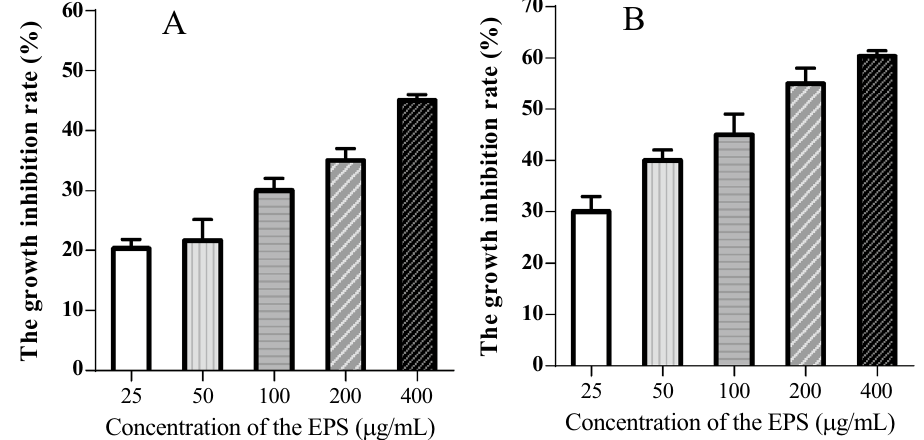
Figure 6. The growth inhibitory effects of EPS on HeLa cells for 24 ( A ) and 48 h ( B ). Data are expressed as the mean ± standard error (n =